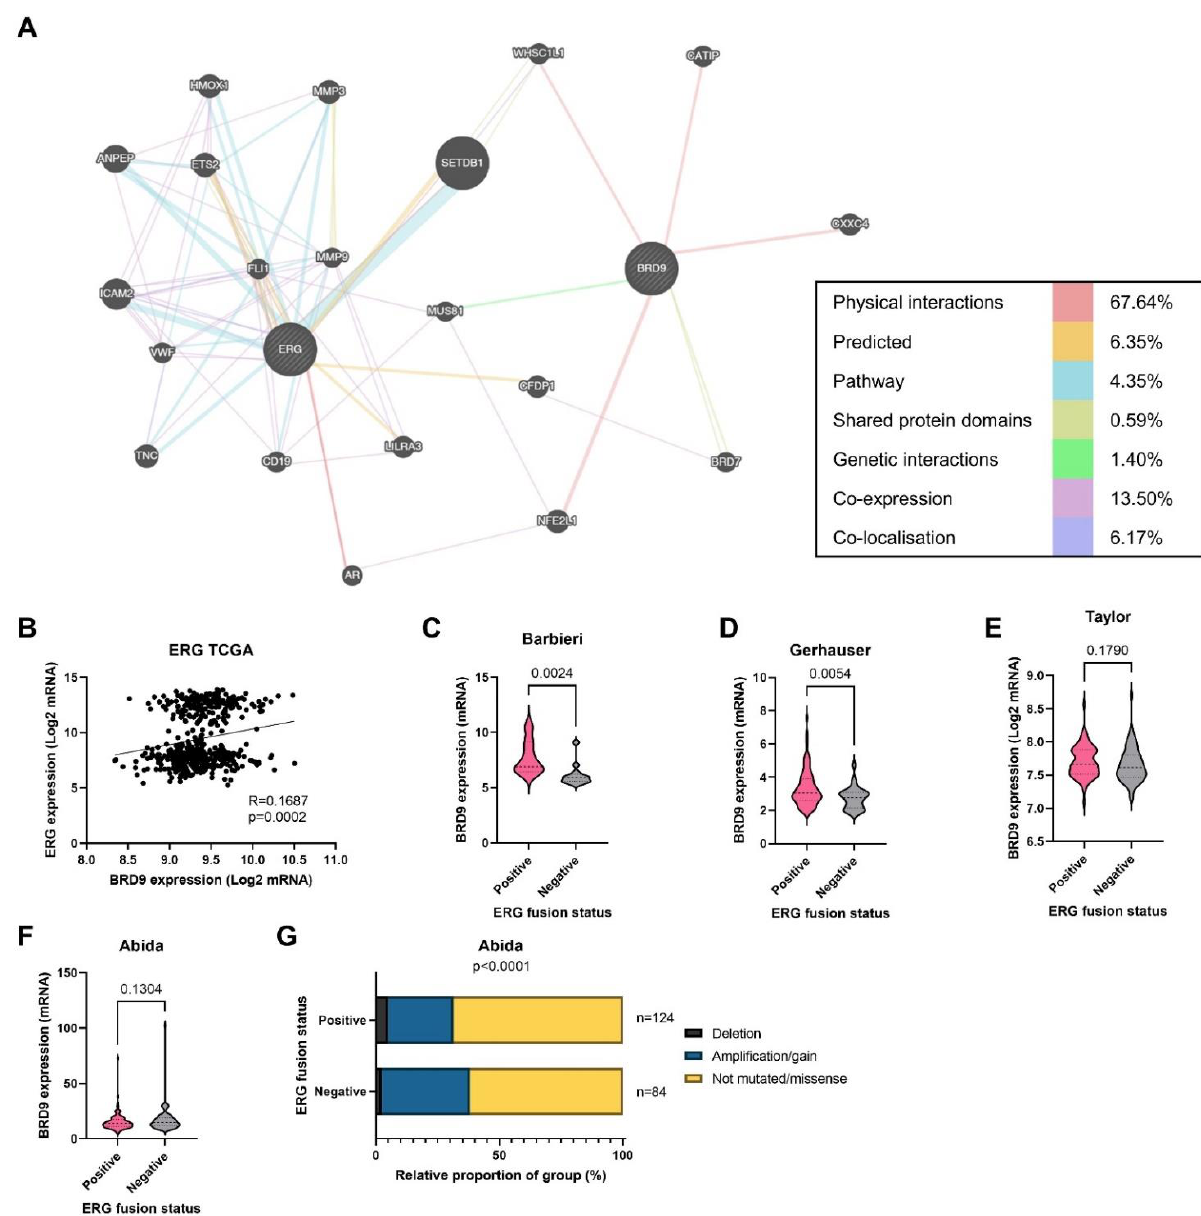
Figure 6. The potential of ERG as a co-target with BRD9 . ( A ) Gene network map showing the associations between BRD9 and ERG . ( B ) Scatterplot with line of best fit showing the correlation between BRD9 and ERG expression in the TCGA cohort. ( C ) Violin plot showing BRD9 expression in who patients were ERG ( TMPRSS2-ETS fusion) positive (right) and negative (left) in the Barbieri cohort. p -value was obtained using a Mann Whitney U test. ( D ) Violin plot showing BRD9 expression in who patients were ERG positive (right) and negative (left) in the Gerhauser cohort. p -value was obtained using a Mann Whitney U test. ( E ) Violin plot showing BRD9 expression in who patients were ERG positive (right) and negative (left) in the Taylor cohort. p -value was obtained using a Mann Whitney U test. ( F ) Violin plot showing BRD9 expression in who patients were ERG positive (right) and negative (left) in the Abida cohort. p -value was obtained using a Mann Whitney U test. ( G ) Stacked bar chart showing BRD9 mutation distribution in patients who were ERG positive and negative and the number of patients in each sample in the Abida cohort. p -value was obtained usi ng Fisher’s exact test. Y axis scales on violin plots vary due to experimental variation. Gene network map created using https://gene- mania.org/. (accessed on 19 April 2021).